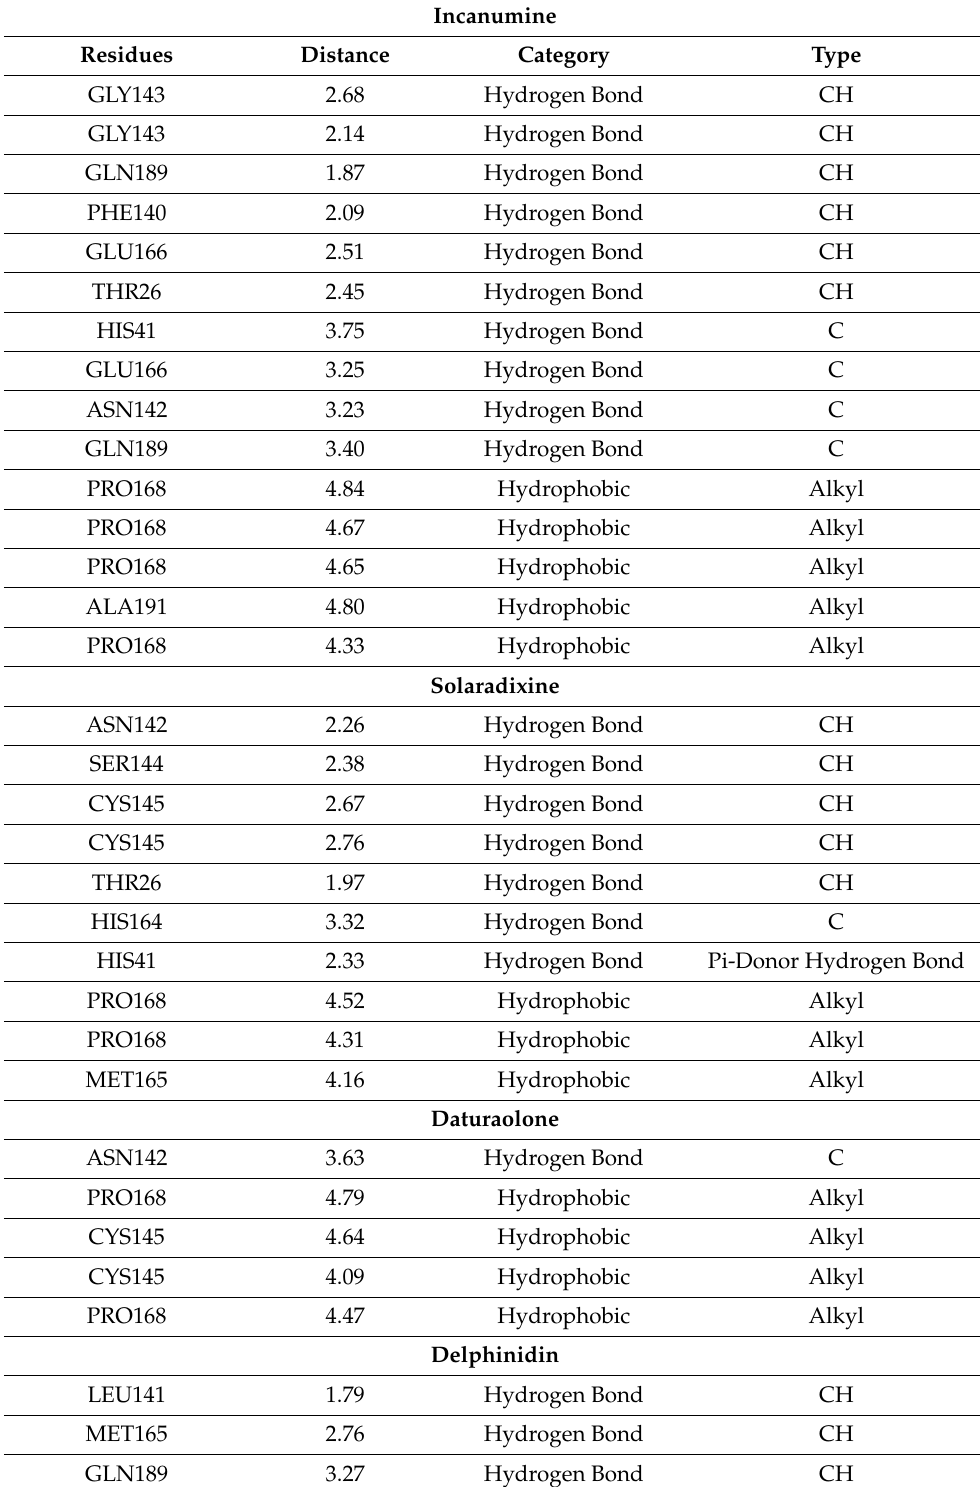
Table 4. Non-bonded interactions of some Solanaceae family phytochemicals with the 3C-like protease of SARS-CoV-2. (CH = conventional hydrogen bond; C = carbon–hydrogen